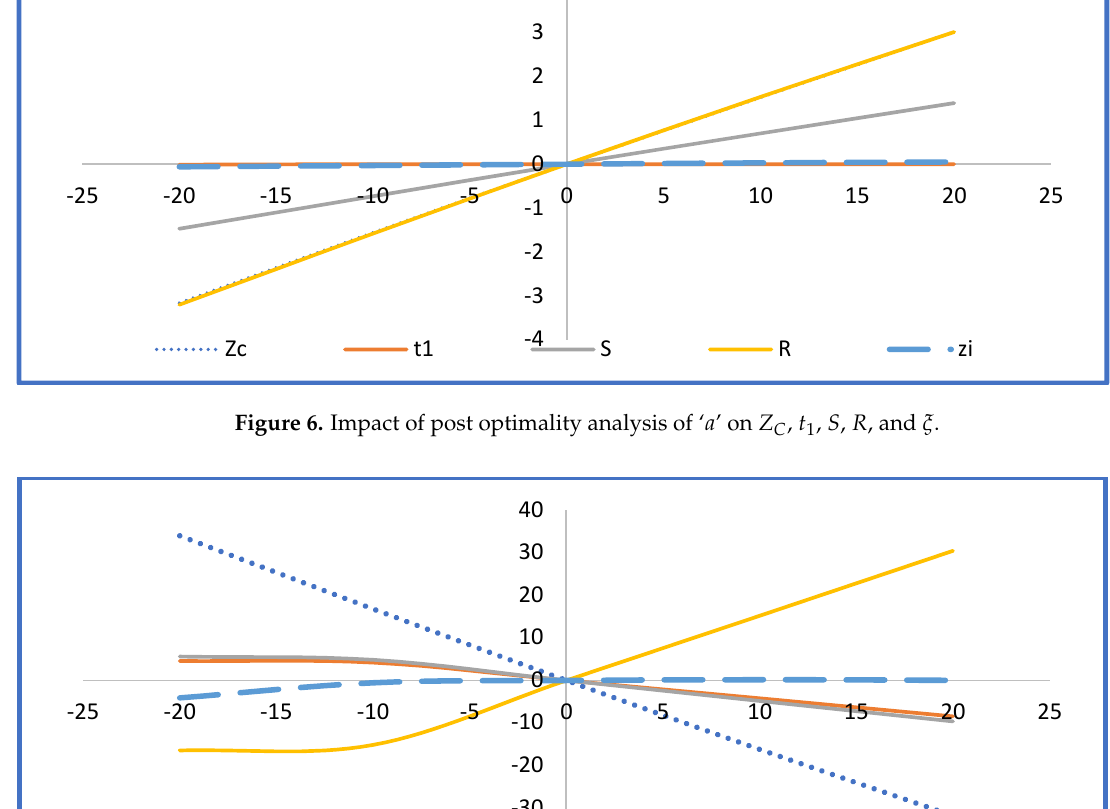
Figure 5. Impact of post optimality analysis of ‘ p ’ on Z C , t 1 , S , R , and ξ .